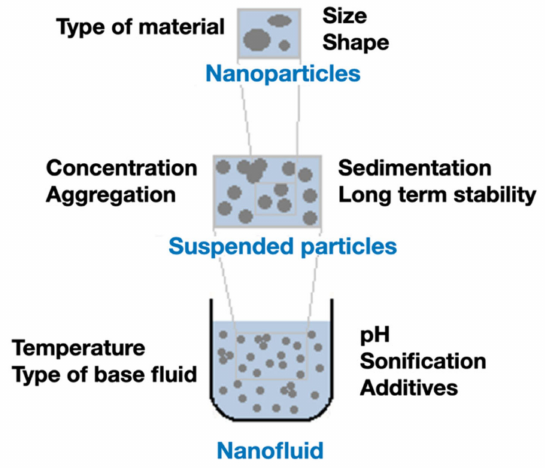
Figure 3. Different properties that affect the thermal conductivity of NFs (Adapted from